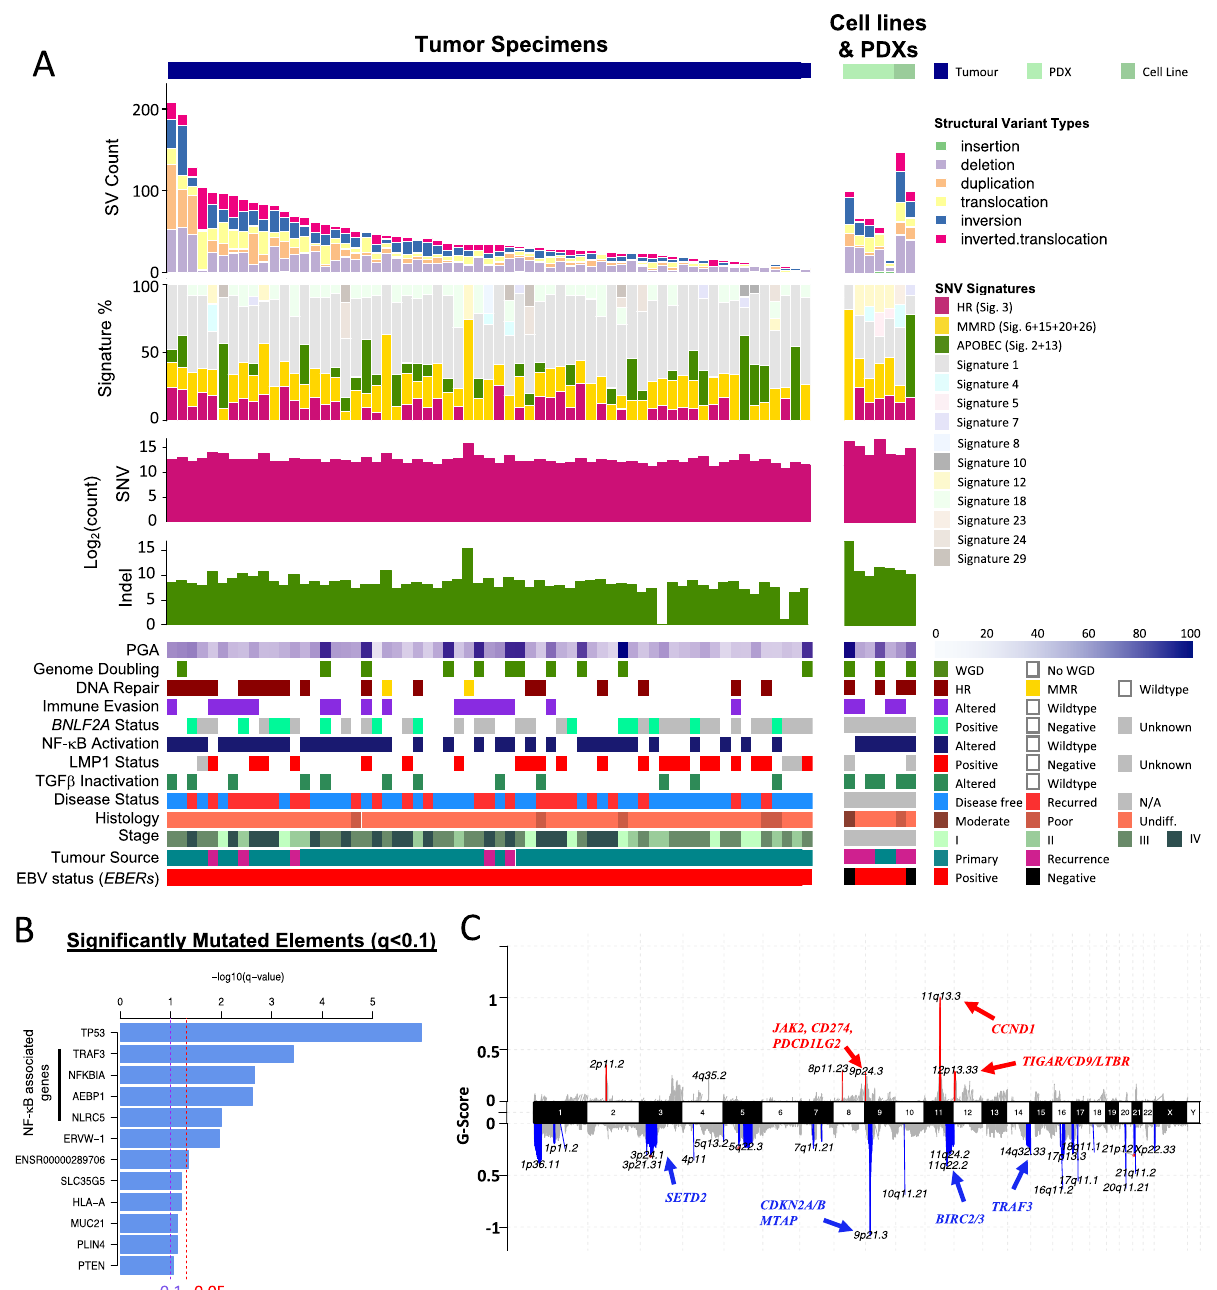
Fig. 1 Whole-genome landscape of NPC. A Somatic gene alterations and mutational signatures of 70 NPC tumors. For each tumor, the number and types of SNVs and SVs, mutation signatures, whole-genome doubling, and percent genome altered (PGA) were shown in the top panels, as well as somatic changes detected in NF- κ B, DNA repair, and TGF- β pathways, expression of EBV-encoded LMP1, BNLF2a and EBERs , clinical staging and tumor type. B Signi fi cantly mutated genes and regulatory elements ( q < 0.1) identi fi ed in NPC. The altered genes in NF- κ B pathways are indicated. C Copy number alterations in NPC. GISTIC copy number variations analysis showing recurrent ampli fi cation and deletion of multiple chromosomal